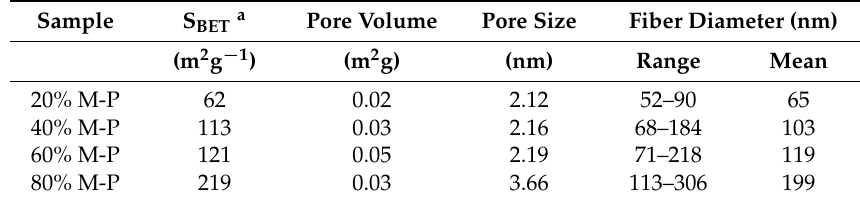
Table 1. Properties of OPM-PAN fibers with different contents of